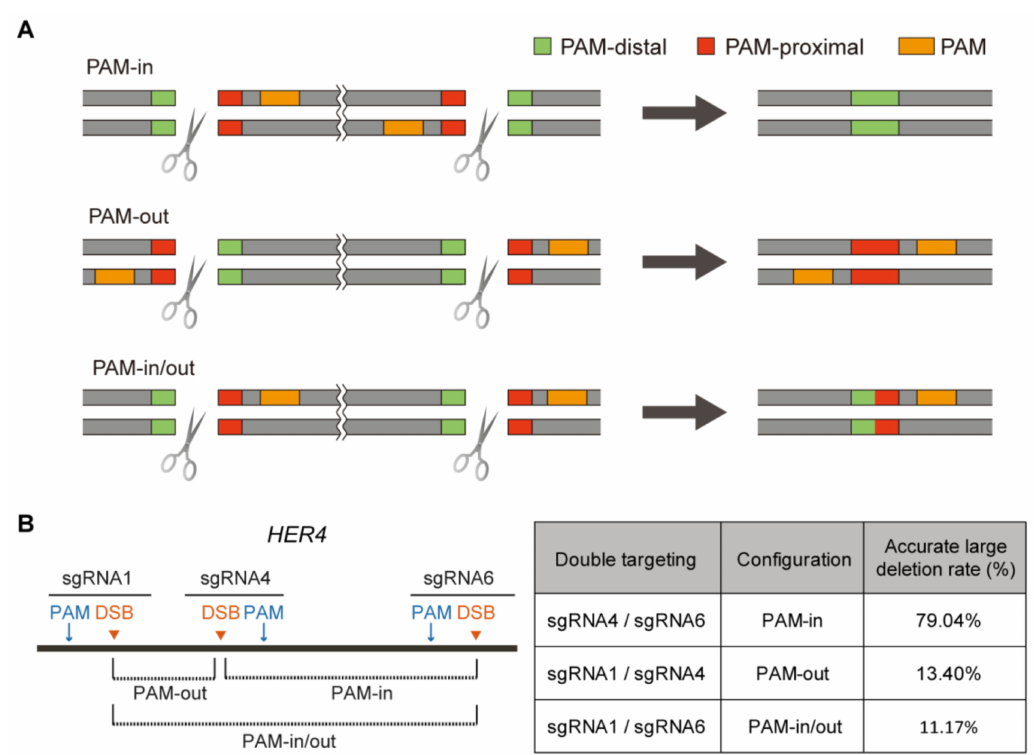
Figure 5. Precise DNA deletion using an NHEJ-mediated DSB repair. ( A ) Schematic illustration of three different deletion configurations. ( B ) ( Left ) The three different deletion configurations in the Her4 gene. ( Right ) The accurate large deletion rate of each